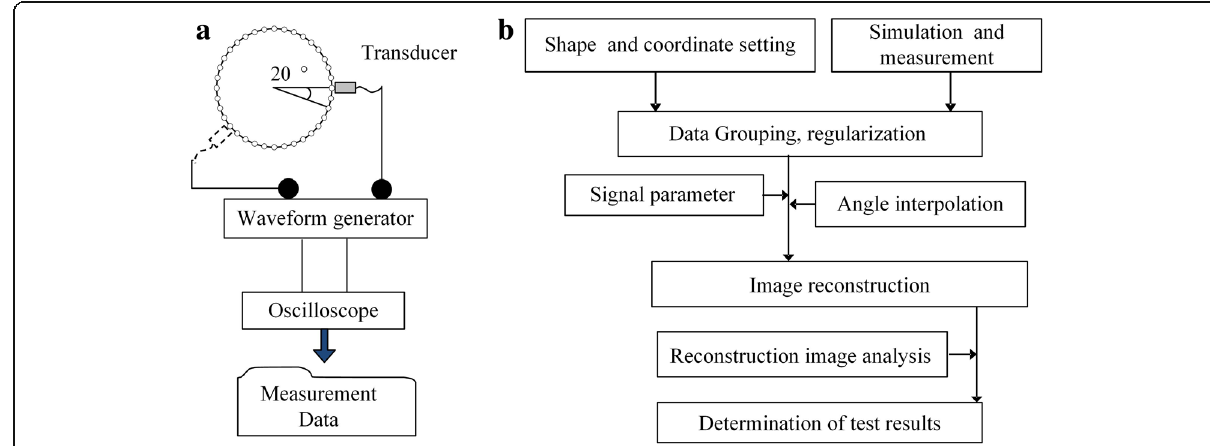
Fig. 2 Data and image reconstruction process: a data collection process, b flowchart for image reconstruction